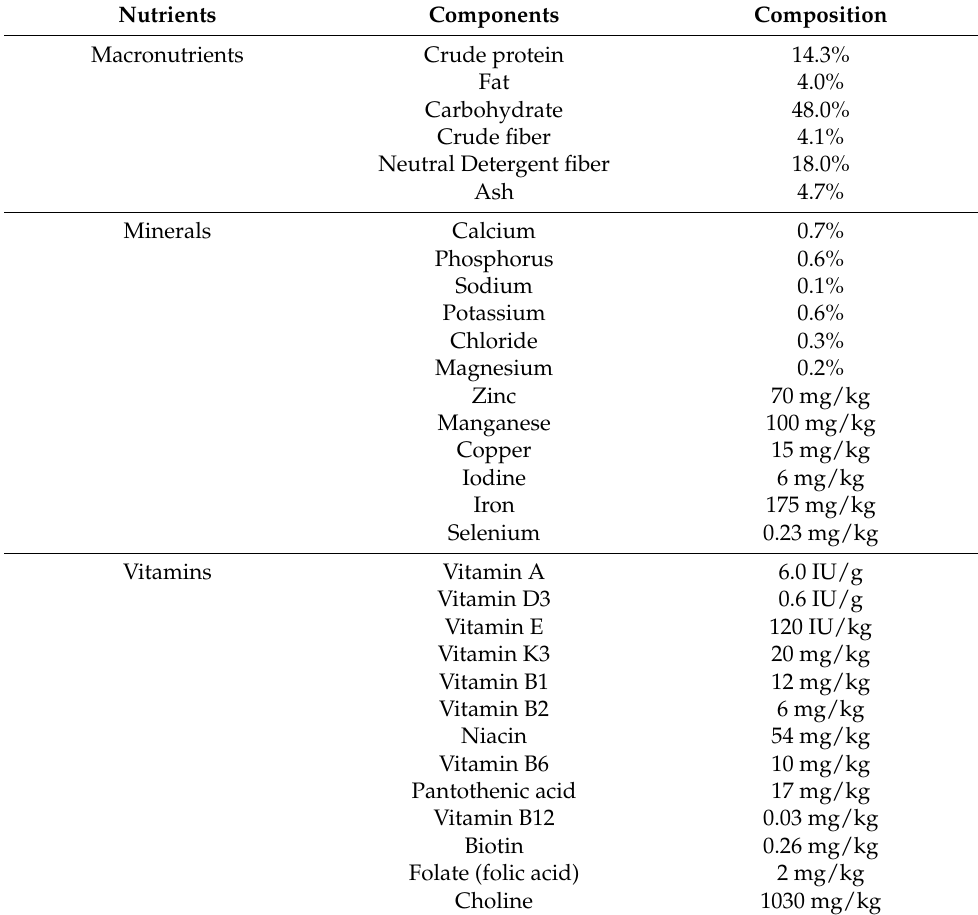
Table 1. Dietary composition of macronutrients, minerals, and vitamins in the standard chow